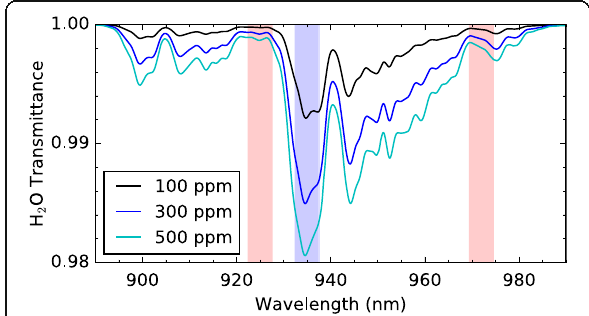
Fig. 4 Transmittance of water vapor in the Martian atmosphere. Values are simulated with a wavelength resolution of 2 nm (FWHM) for volume concentrations of 100, 300, and 500 ppm. The blue band indicates the wavelength band around the absorption peak centered at 935 nm with a band width of 5 nm, and the two red bands indicate the wavelength band outside the absorption band centered at 935 and 972 nm with a band width of 5